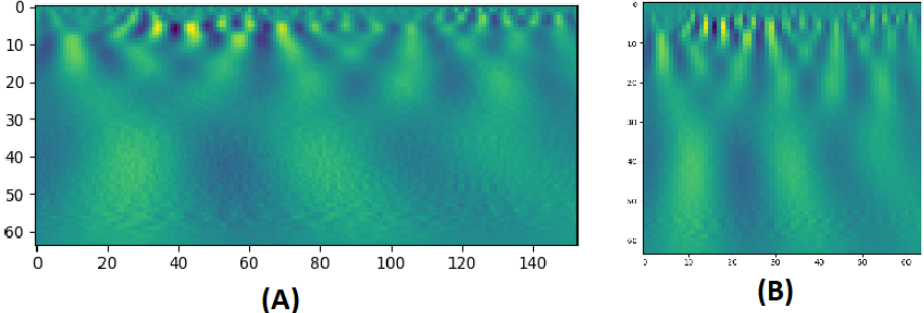
Figure 2. ( A ) A CWT scalogram example with 64 scales of a BOLD signal of 153 time points. ( B ) The resized version of size: 64 ×